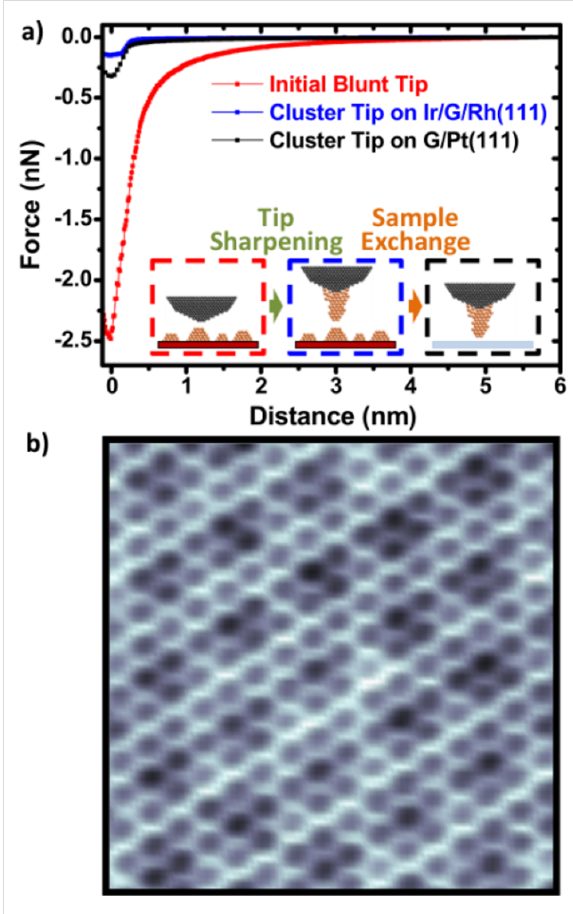
Figure 1: Sharpening of a blunt tip and study of its stability after a macroscopic sample exchange. (a) F (z) curves corresponding to the milestones in the sharpening process. The red curve corresponds to the initial blunt tip. The blue curve, measured in the same Ir/G/Rh(111) sample, shows the decrease of the vdW force after the sharpening with clusters. The black curve is obtained with the same tip after exchanging the sample with a G/Pt(111) surface. Acquisition parame- ters: f o = 168274 Hz; k = 33.3 N/m; red curve: V CPD = − 0.1 V; A = 13.5 nm. Blue curve: V CPD = − 0.45 V; A = 16 nm. Black curve: V CPD = +0.2 V; A = 19.2 nm. (b) Atomically resolved NC-AFM image of the G/Pt(111) surface obtained with the cluster tip. Image